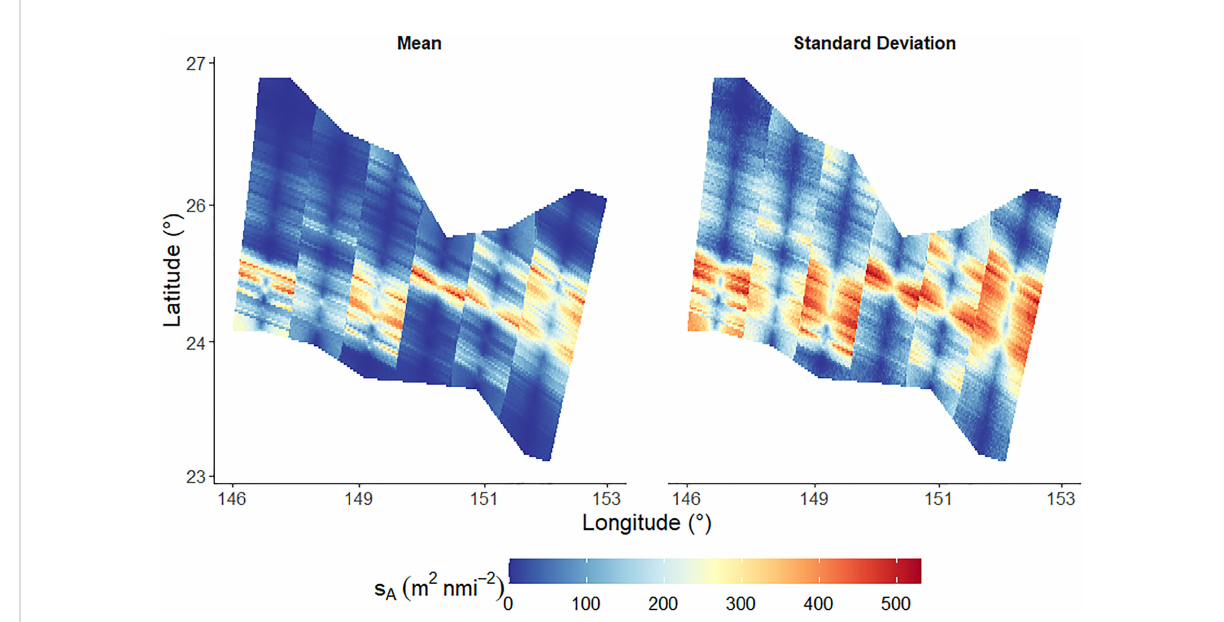
FIGURE 10 Mean of n sim simulations of Nautical area scattering coef fi cient, s A . The left plot indicates the mean s A at all locations within the survey domain and the right plot indicates the corresponding mean standard deviations.